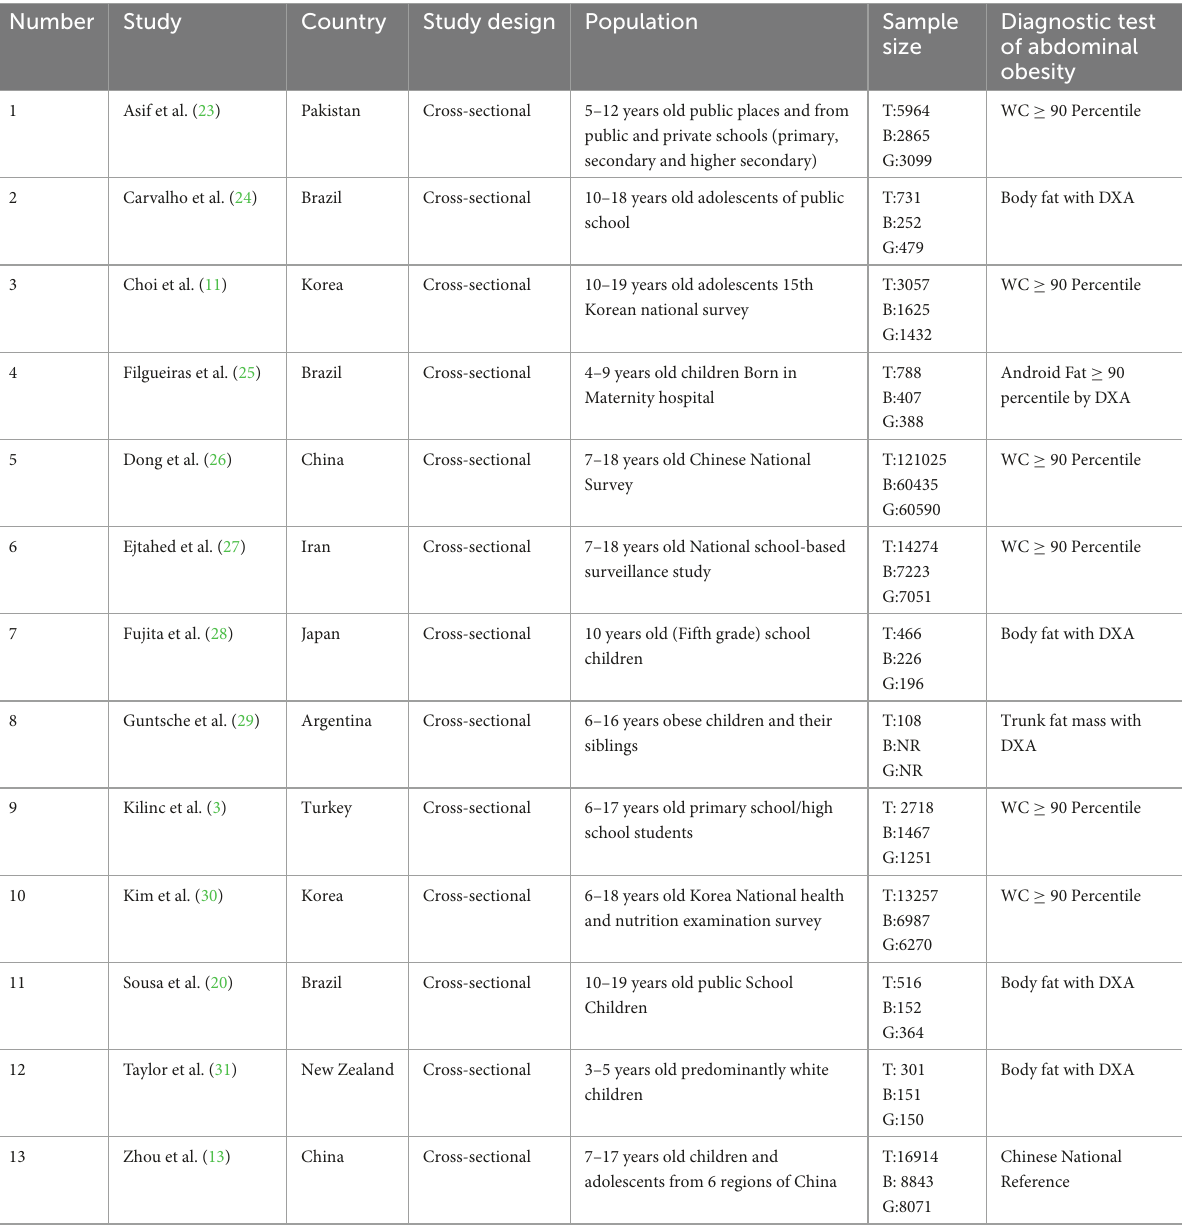
TABLE 1 General characteristics of included